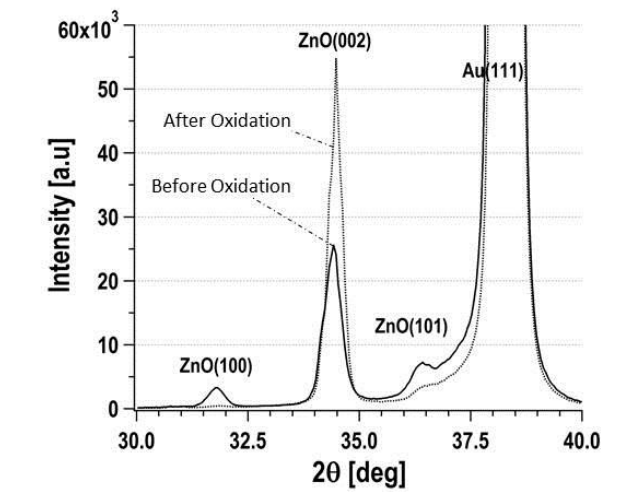
Figure 4. XRD patterns of ZnO nanostrucuture on the quartz crystal. Dash line and continuous line were measured before and after the thermal oxidation,